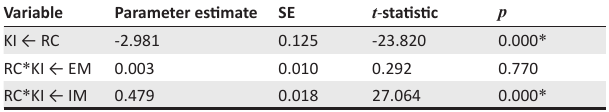
TABLE 4: Model parameter estimates and p -values.